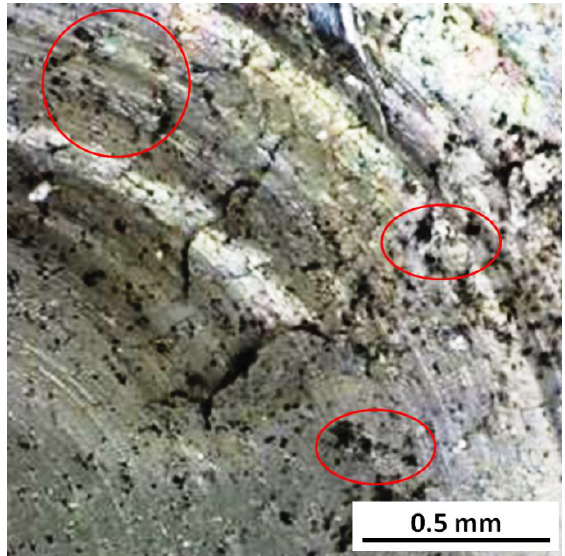
Figure 1. Optical image of a main landing gear fastener hole showing examples of corrosion pitting (circled), multiple rings from drilling, and two machining laps: material: aluminium alloy (AA) 2014-T6, adapted with permission from [10]. Copyright 2018 DST Australia.